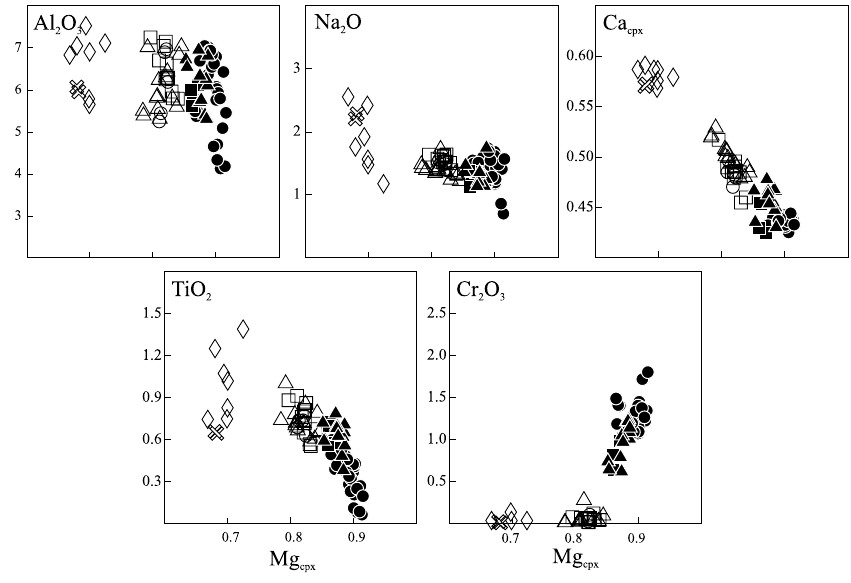
Fig. 4 – Variation of Al 2 O 3 , TiO 2 , Na 2 O, Cr 2 O 3 and Ca cpx vs. Mg cpx for clinopyroxenes from the Janjão,